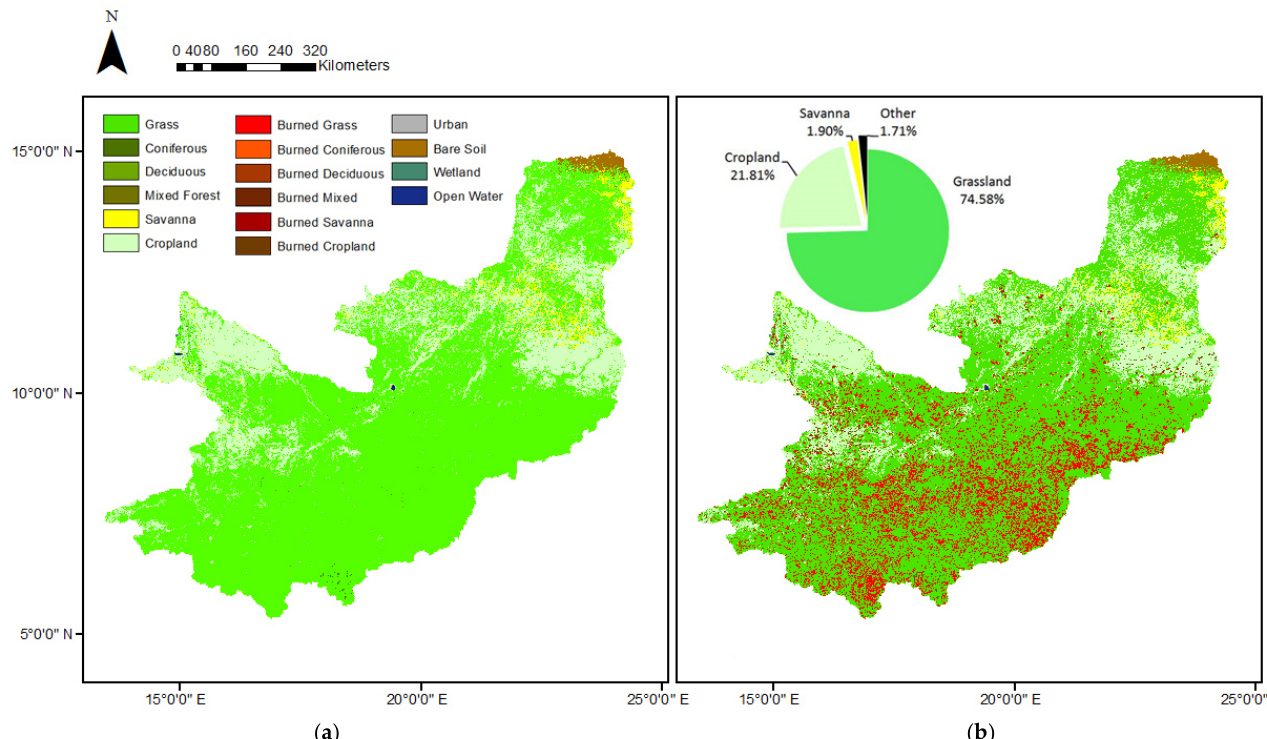
Figure 3. MOD14 fire counts from the wet season in August 2010 ( a ) and burning season month, January 2010 ( b ).